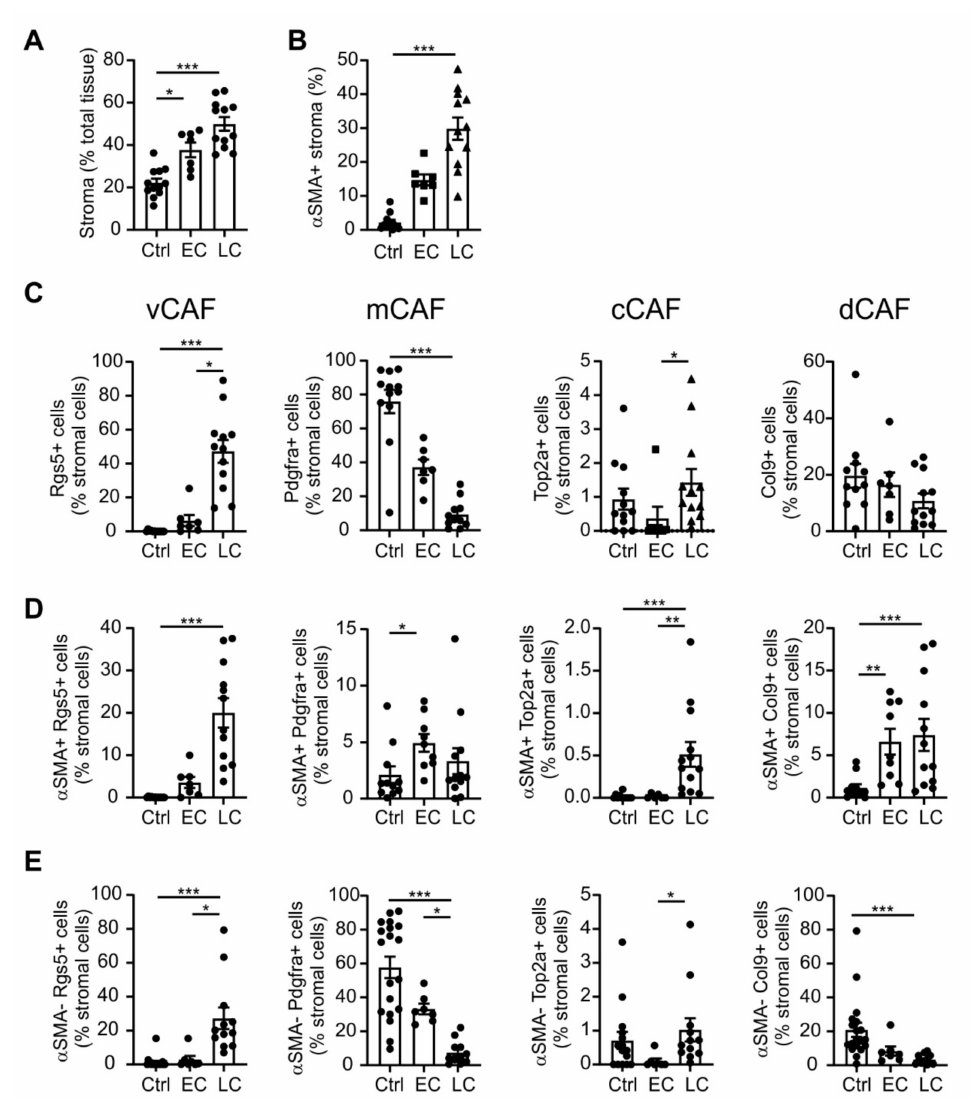
Figure 2. Quantitative analysis of cancer-associated fibroblast (CAF) subset marker expression during PyMT tumor development. Untransformed mammary glands (Ctrl) as well as early (EC; 8–12 weeks) and late-stage (LC; 18–20 weeks) PyMT tumors were harvested. CAF subset marker expression ( α SMA, activated fibroblasts; Rgs5, vascular CAF (vCAF); Pdgfra, matrix CAF (mCAF); Top2a, cycling CAF (cCAF); Col9, developmental CAF (dCAF)) and tissue category abundance were analyzed by histology as in Figure 1. The abundance of stroma ( A ) and total α SMA + stromal cells ( B ), as well as expression of CAF subset markers in total stroma ( C ), α SMA + stromal cells ( D ) and α SMA − stromal cells ( E ). Individual data points indicate mean expression of markers in tissue sections of one individual animal (twelve individual animals were analyzed in the Ctrl and LC groups, and seven in the EC group). Additionally, means ± SEM are shown. p -values were calculated using one-way ANOVA